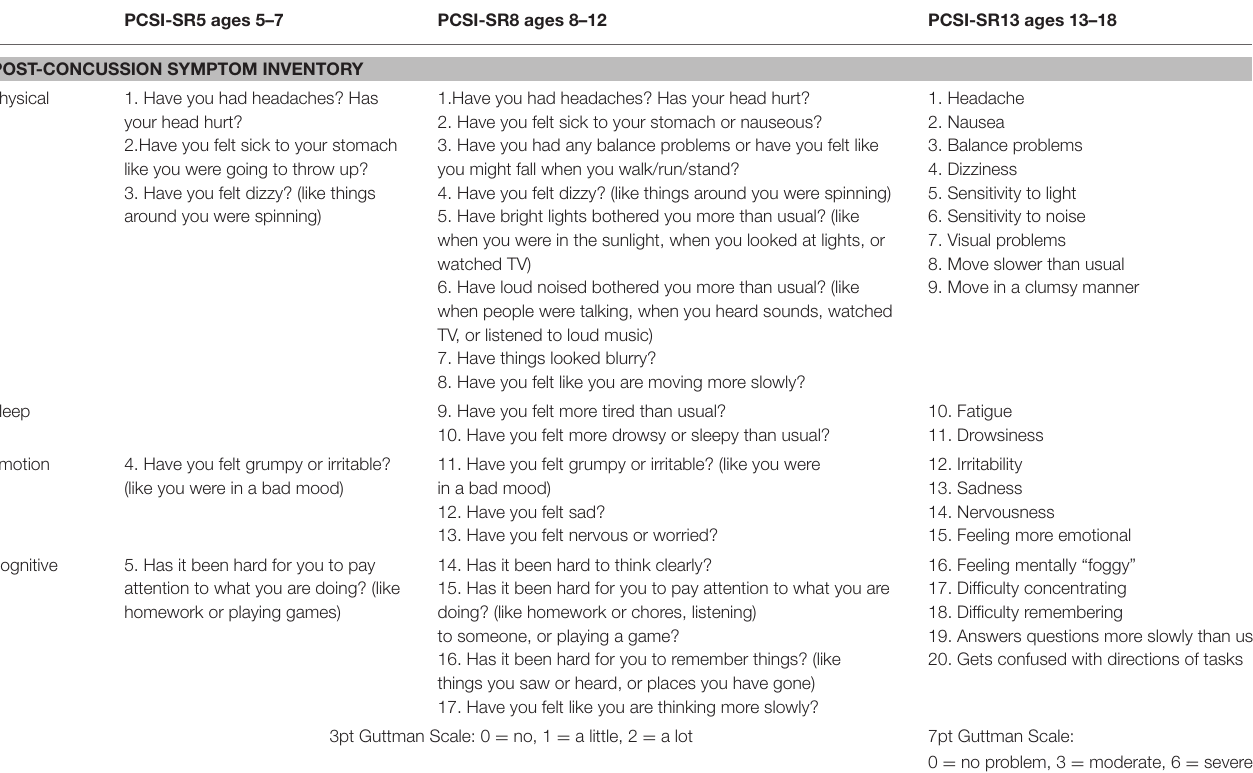
TABLE 1 | List of symptoms provided on each version of the